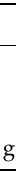
Figure 2. The schematic of the microchannel heat exchanger assembly, side-view. Polymethyl methacrylate (PMMA). ( a ) Parts of the condenser; ( b ) a photo of the condenser (as fabricated). Table 2. The accuracies and ranges of the testing